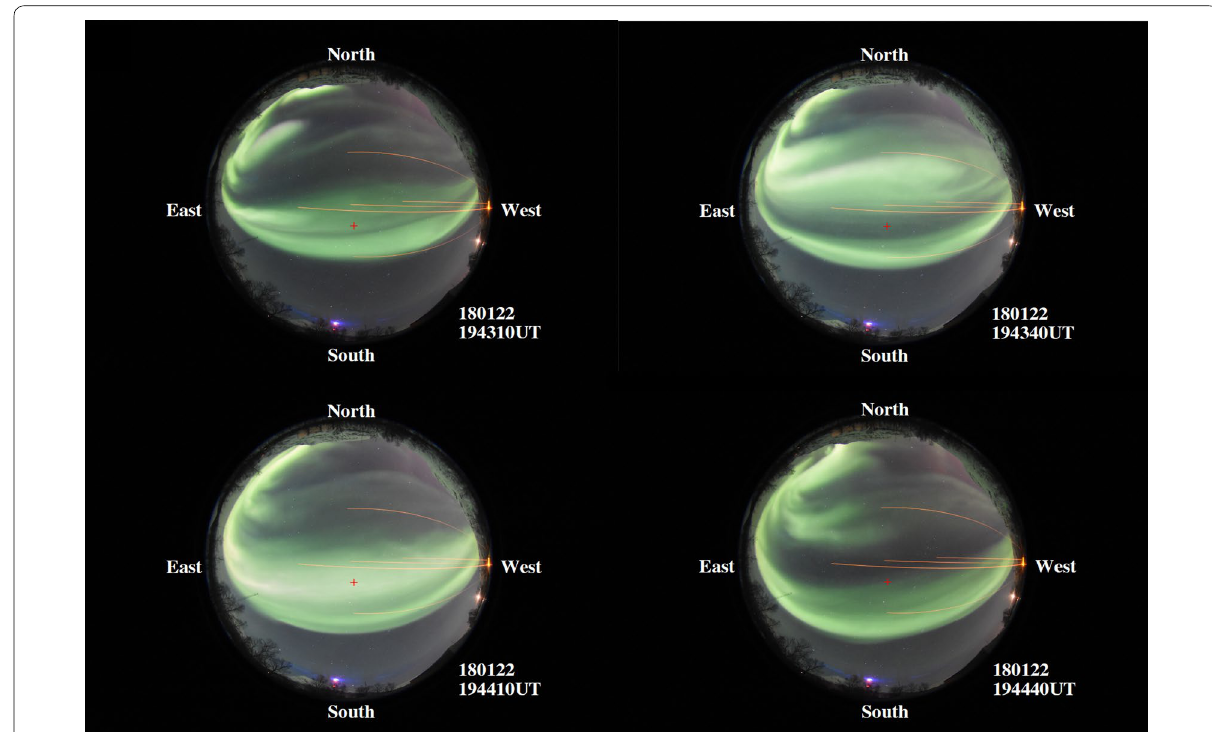
Fig. 16 All-sky images taken with a digital camera (Nikon D7200) every 30 s with exposure time of 8 s between 19:43:10 UT and 19:44:40 UT on January 22, 2018. The field-aligned position, where the photometer was pointed, was indicated by a red plus sign (